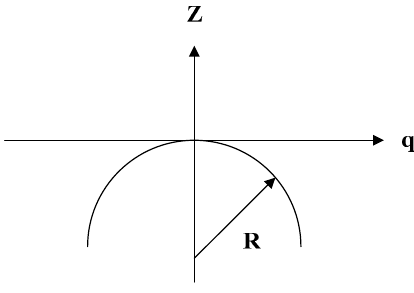
Figure 3. Spherical curve dimensions.